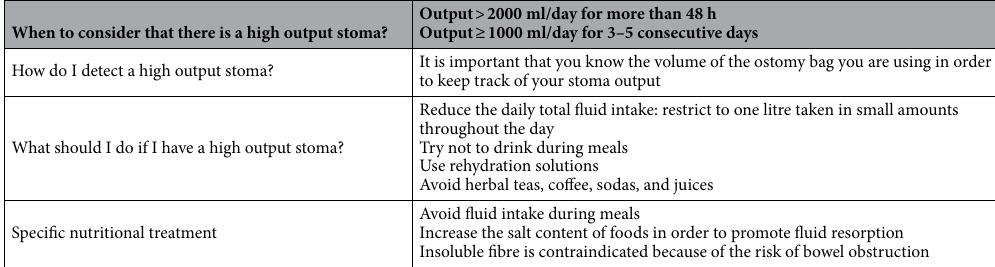
Table 4. High output stoma detection and